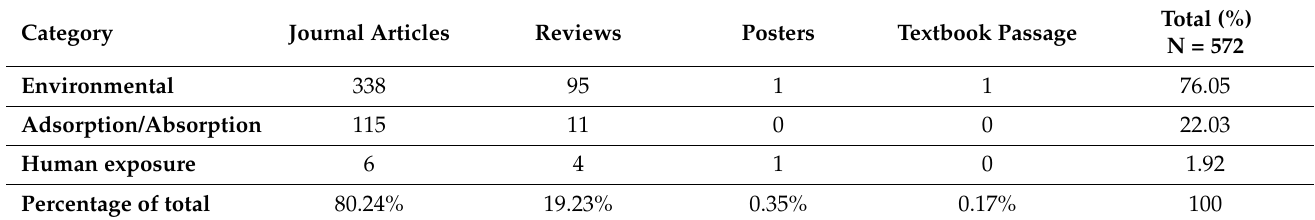
Table 2. Categories identified in scoping review, by type of publication.